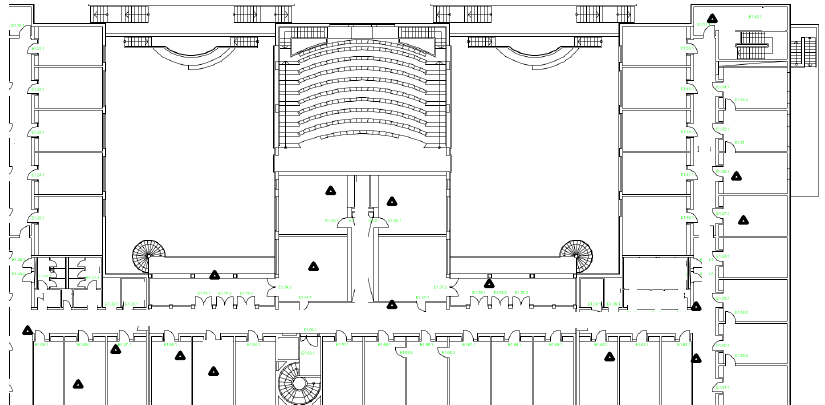
Figure 9. Building layout for the indoor localization experiment and the robot trajectory. The triangles mark the positions of sensor nodes, which are placed either in the offices or along the